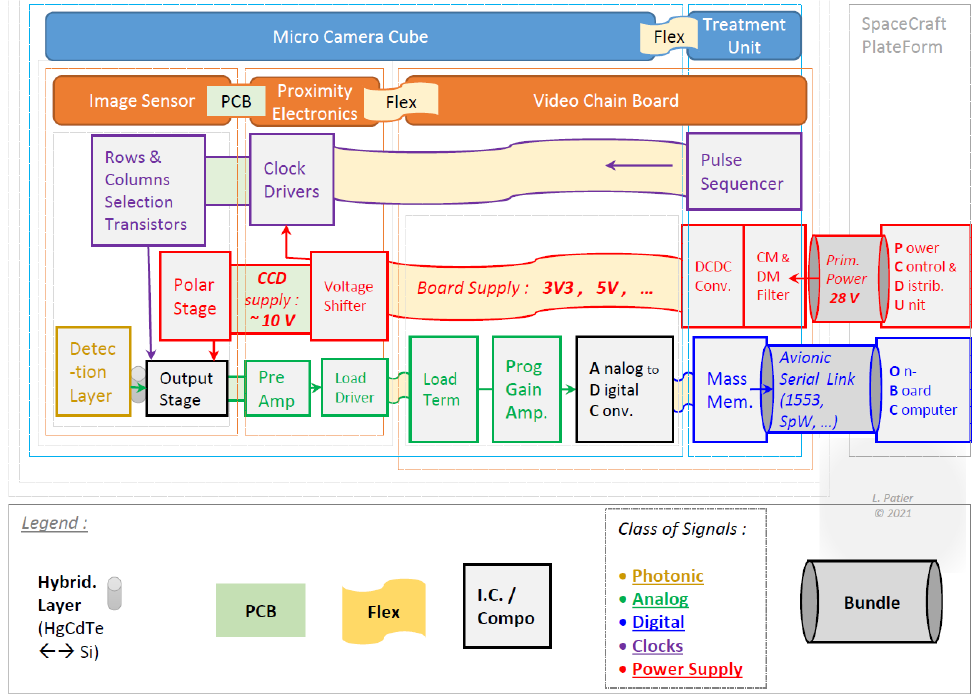
Figure 1. Electronic Architecture of a Space Detection